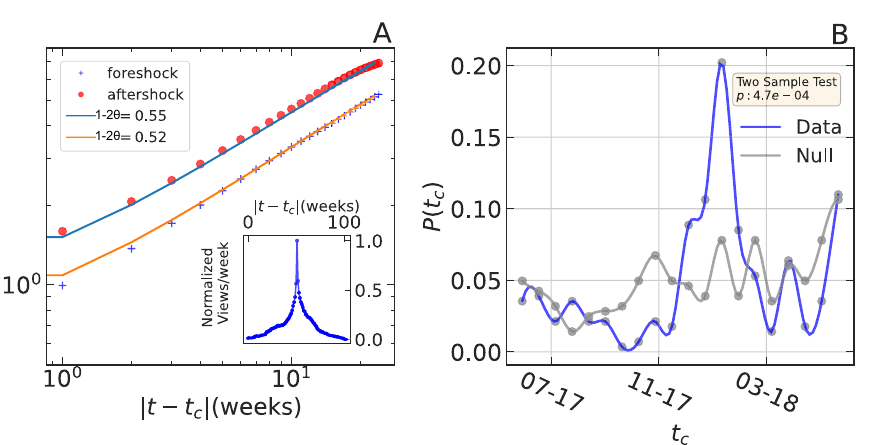
Figure 3. Synchronized endogeneity in YouTube success: ( A ) cumulative precursory (“foreshock”) and relaxation (“aftershock”) of weekly view counts of the 399 YouTube content creators (see text). The scaling laws are with exponent ∼ 0.5 . The inset figure shows the peak-centered average weekly views. ( B ) The probability distribution of the time of the highest weekly views for the YouTube channels. The blue line is obtained from the data, and the gray line is for the null distribution constructed by randomly shuffling the daily weekly counts. The p value of the two-sample Kolmogorov–Smirnov test result is given in the yellow